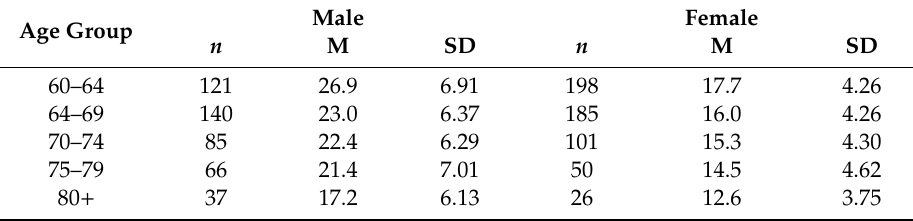
Table 7. Grip strength based on age group and gender, Unit: kg.